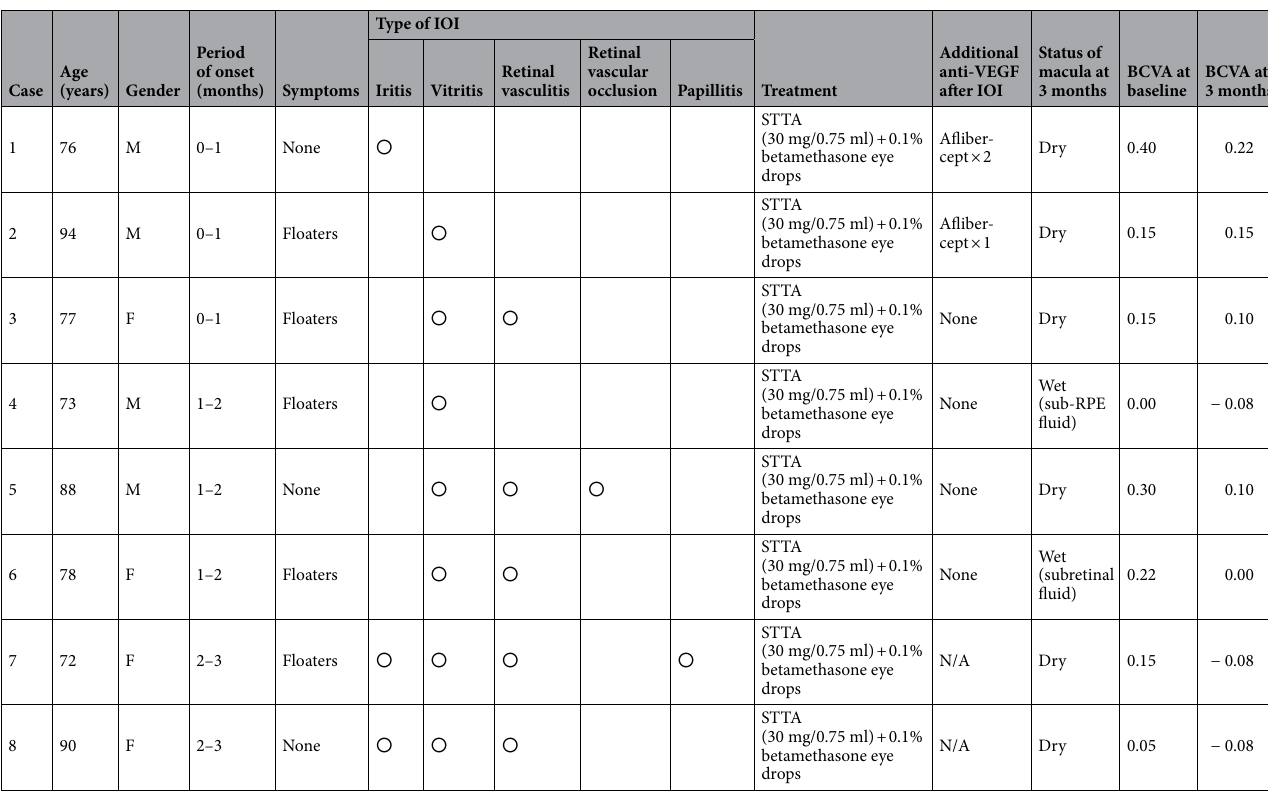
Table 1. Demographic and clinical characteristics of cases with intraocular inflammation after brolucizumab injection. IOI intraocular inflammation, VEGF vascular endothelial growth factor, BCVA